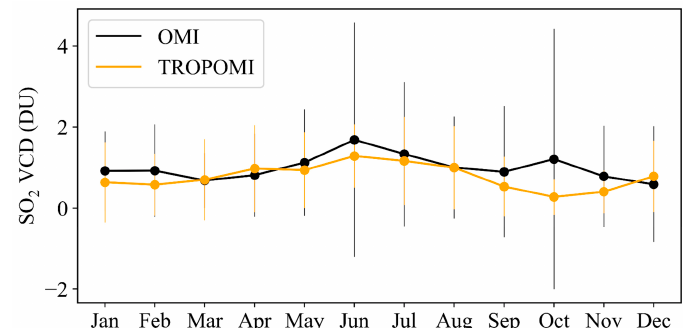
Figure 9. Seasonal variation of SO 2 emitted from Mt. Nyiragongo.